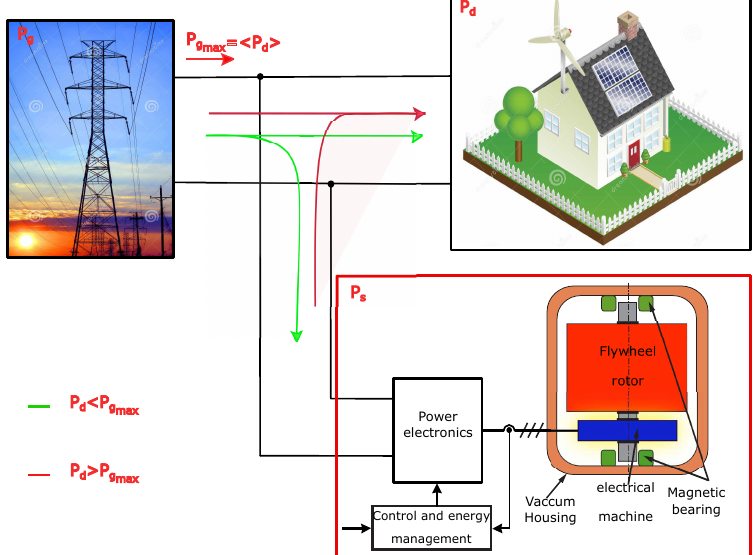
Figure 5. Conceptual overview of FESS in domestic application.